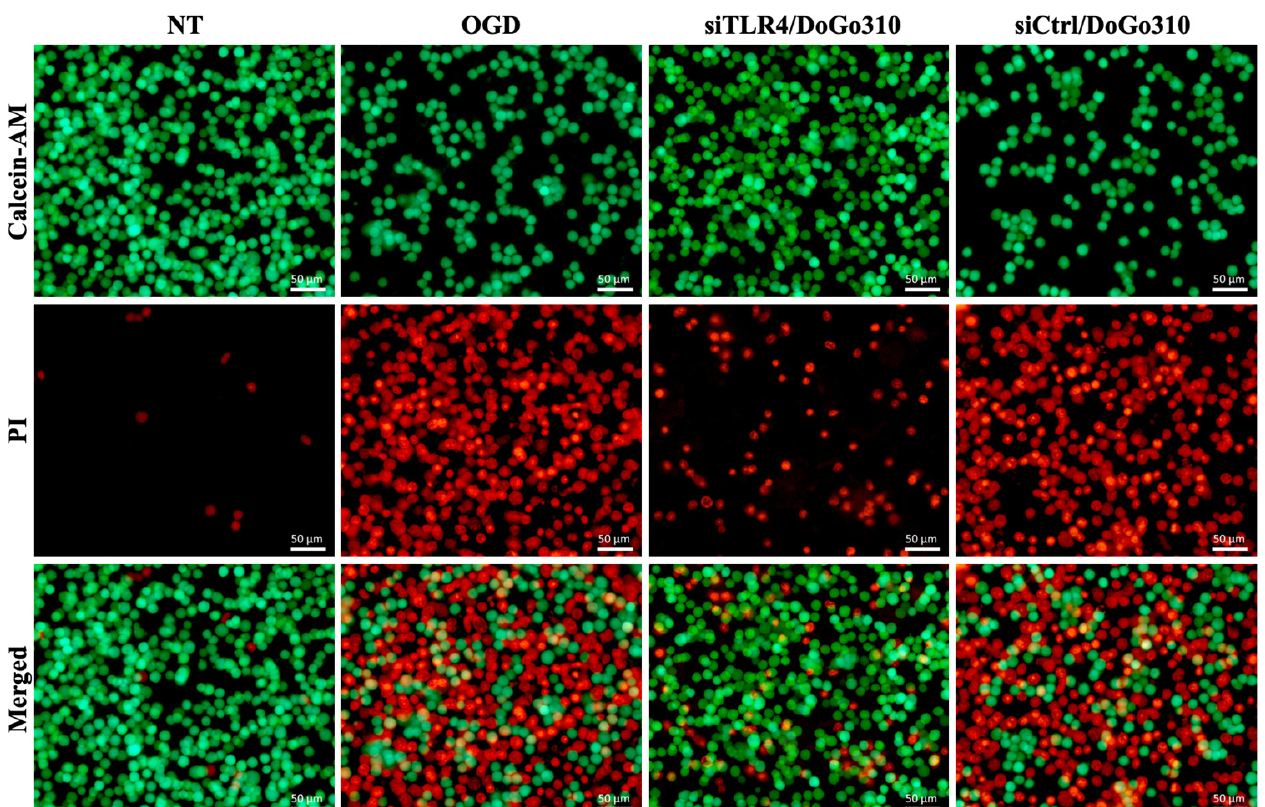
Figure 5. DoGo310 LNP-mediated silencing of TLR4 in OGD-treated microglia reduces neurotoxicity. OGD-treated microglia were treated with either siTLR4/DoGo310 LNPs, or siCtrl/DoGo310 LNPs. Then, the culture media was harvested from each group and was added to N2a cells. Red represents dead cells stained by PI; green represents live cells stained with Calcein-AM. NT, nontreated. Scale bar = 50 mm.